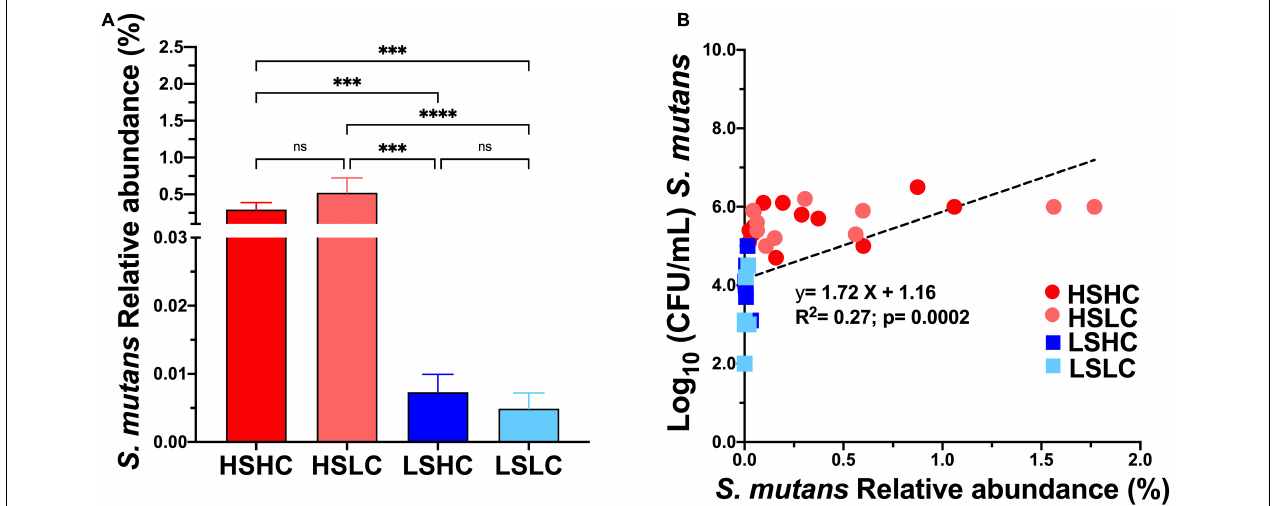
FIGURE 3 | Salivary S. mutans levels detected with culture based method versus microbiome sequencing. The relative abundance of S. mutans detected on saliva upon 16S rRNA sequencing (A) per group (HSHC, HSLC, LSHC, and LSLC). (B) Linear regression analysis between the S. mutans levels detect by culture based (CFU’s/mL) and 16S RNA sequencing (% Relative abundance). The graphic bars represent means, and error bars represent the standard deviation (SD). Differences in significance between groups were analyzed using one-way ANOVA followed by Kruskal–Wallis multiple comparisons tests; ∗∗∗ p < 0.0005, ∗∗∗∗ p < 0.00005.